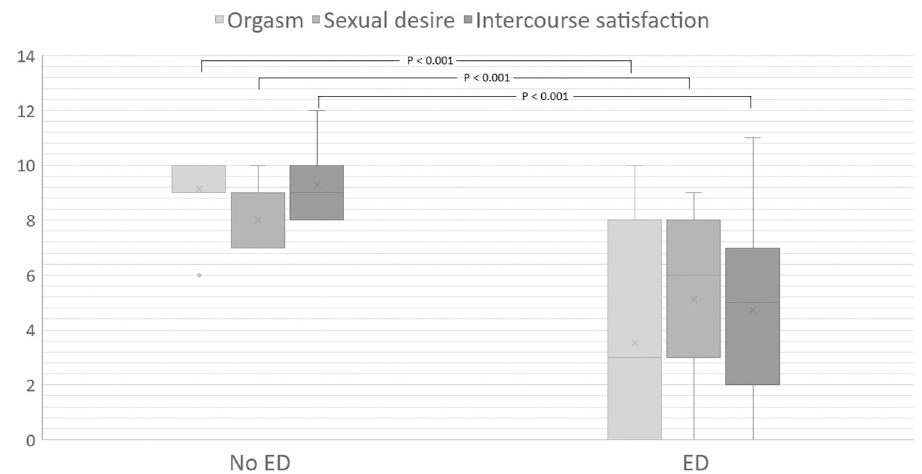
Fig 1. IIEF-15 score in another domain classified by ED. ED erectile